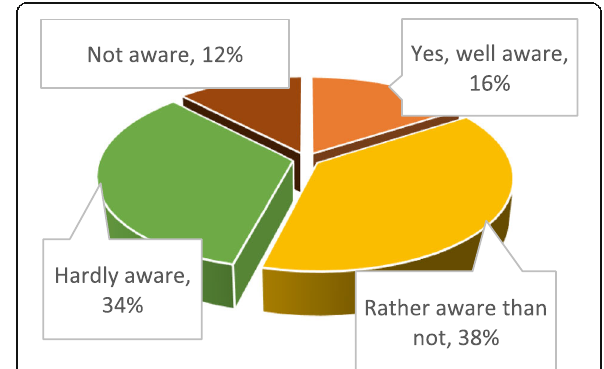
Fig. 4 Ukrainian pharmacy students ’ attitude to including data on medical cannabis and cannabinoids in academic